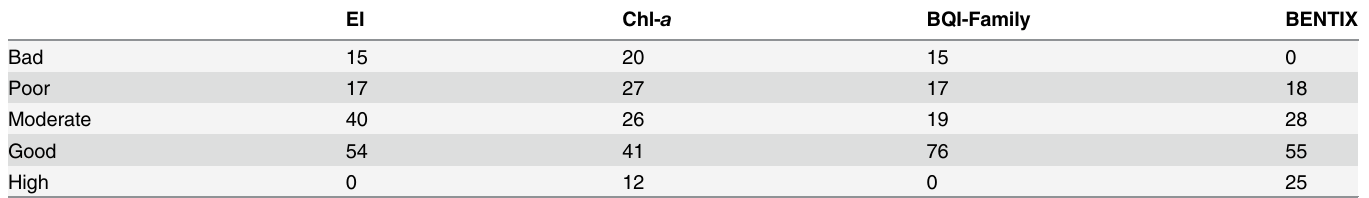
Table 2. Number of sampling stations in each Ecological Status category according to four seawater column and benthic indices. Chl- a , chlorophyll a ; EI, Eutrophic Index; BQI-Family, Benthic Quality Index — Family; BENTIX, Benthic Index.